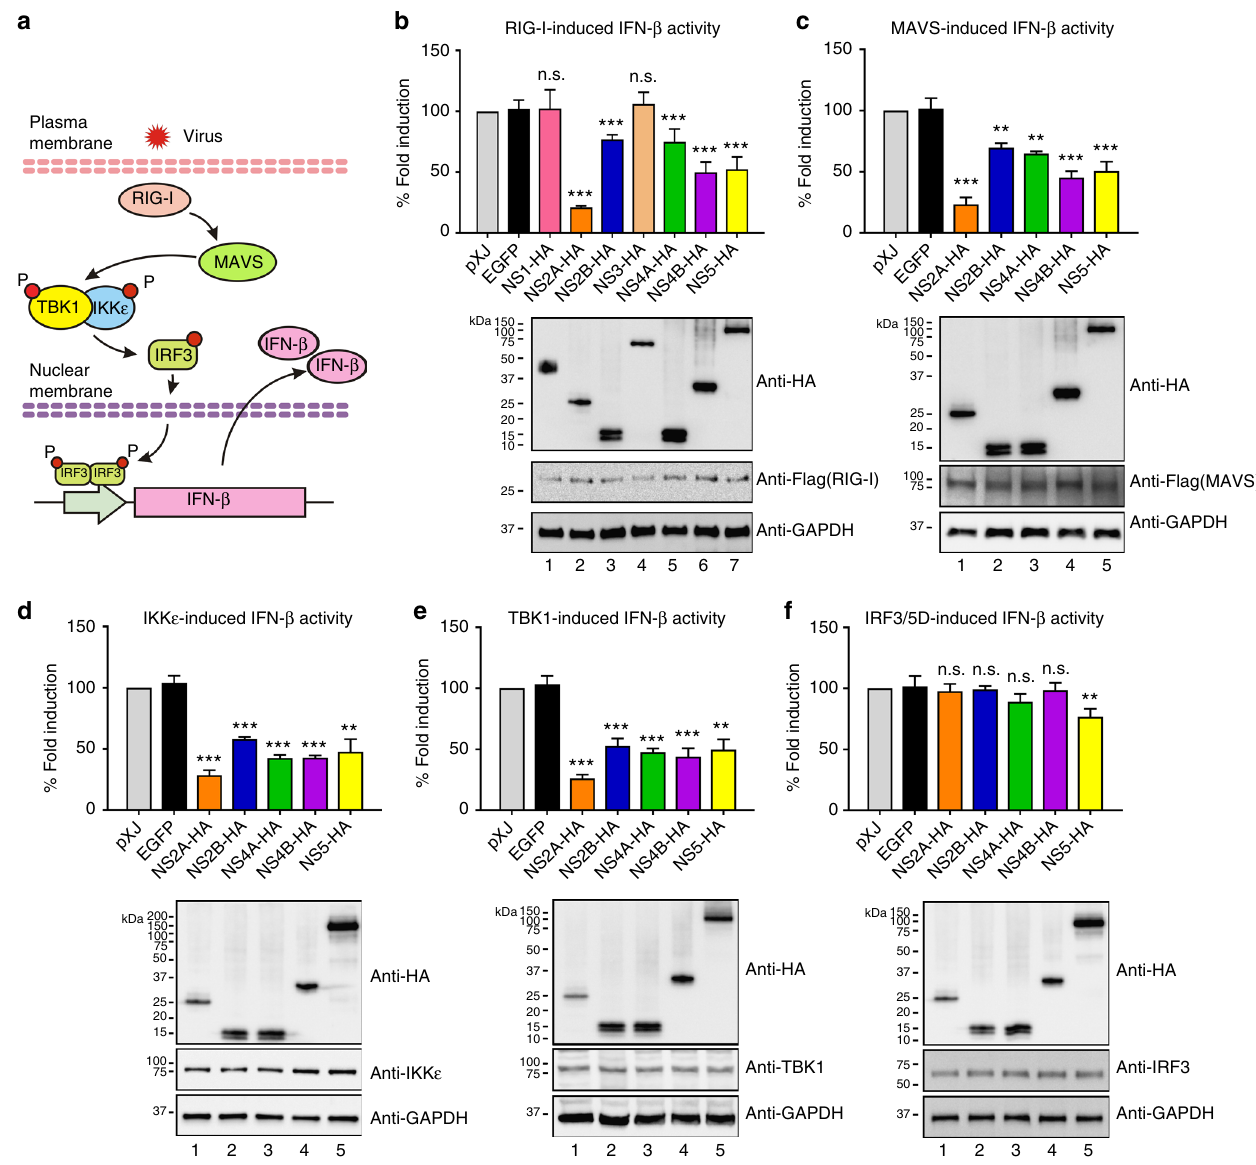
Fig. 1 ZIKV non-structural proteins inhibit IFN- β production through the RIG-I pathway. a Schematics of the RIG-I mediated IFN- β production pathway.